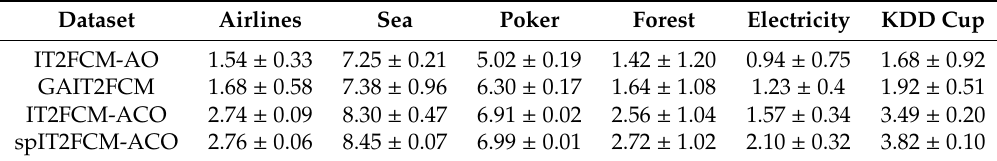
Table 4. Evaluation of PCAES